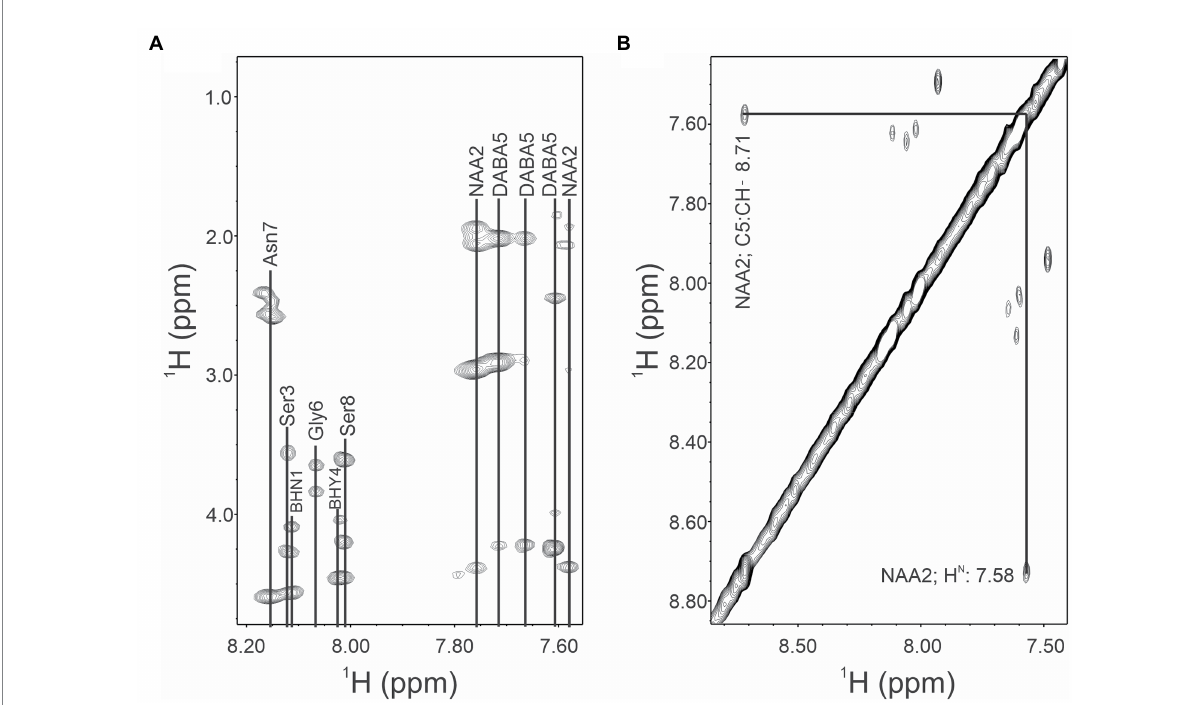
FIGURE 3 TOCSY and NOESY NMR spectra of occidiofungin. (A) . TOCSY spin system correlations of the aldehyde occidiofungin product. Fingerprint region (NH correlations), alpha to side chain correlations and side chain correlations are shown. Abbreviation are: diamino butyric acid 5 (DABA5), novel amino acid 2 (NAA2), beta-hydroxy-asparagine 1 (BHN1), and beta-hydroxy-tyrosine 4 (BHY4). (B) . NOESY spin system correlations. The expansion shows the intra-residue NOE interaction of the aldehyde proton of NAA2 to the amide proton of the